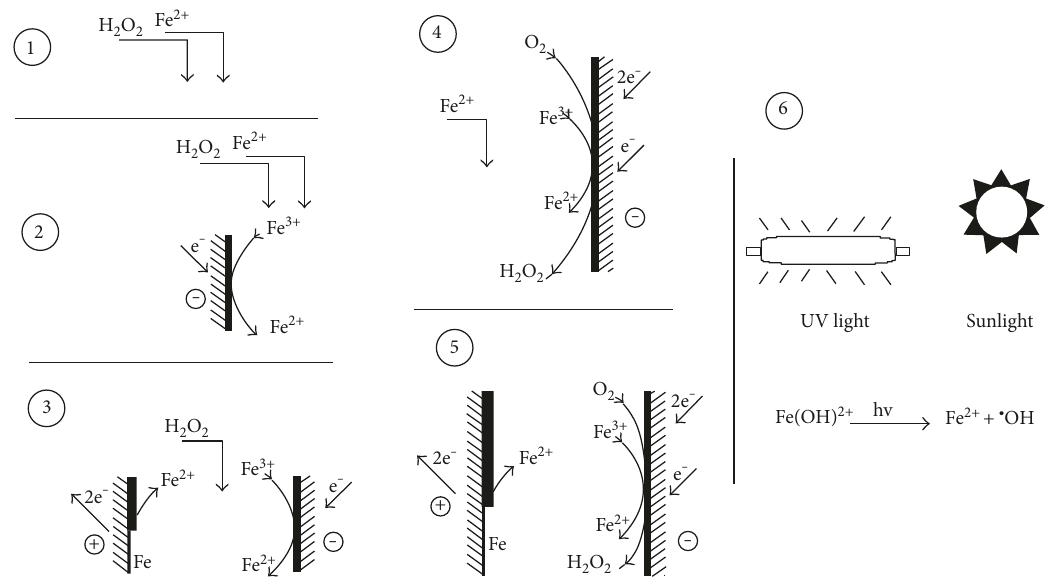
Figure 1: Classical Fenton (CF) and electrochemical Fenton (EF) oxidation processes: (1) CF, (2) Fered-Fenton (EF-FeRe), (3) electrochemical peroxidation/anodic Fenton (EF-FeOx), (4) electro-Fenton (EF- H (6)